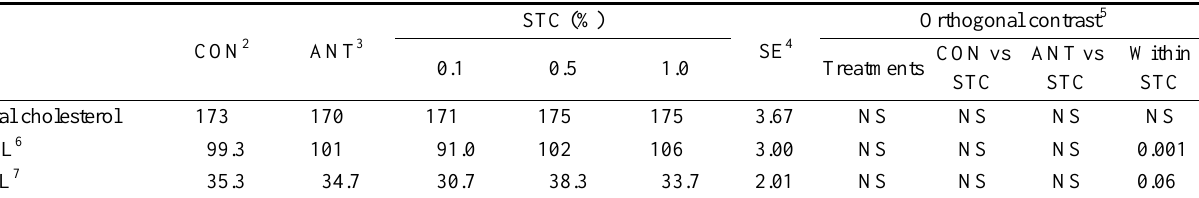
Table 5. Least squares means for the effect of dietary sea tangle ( L. japonica ) and charcoal supplementation on serum biochemical parameters of duck (mg/dL) 1